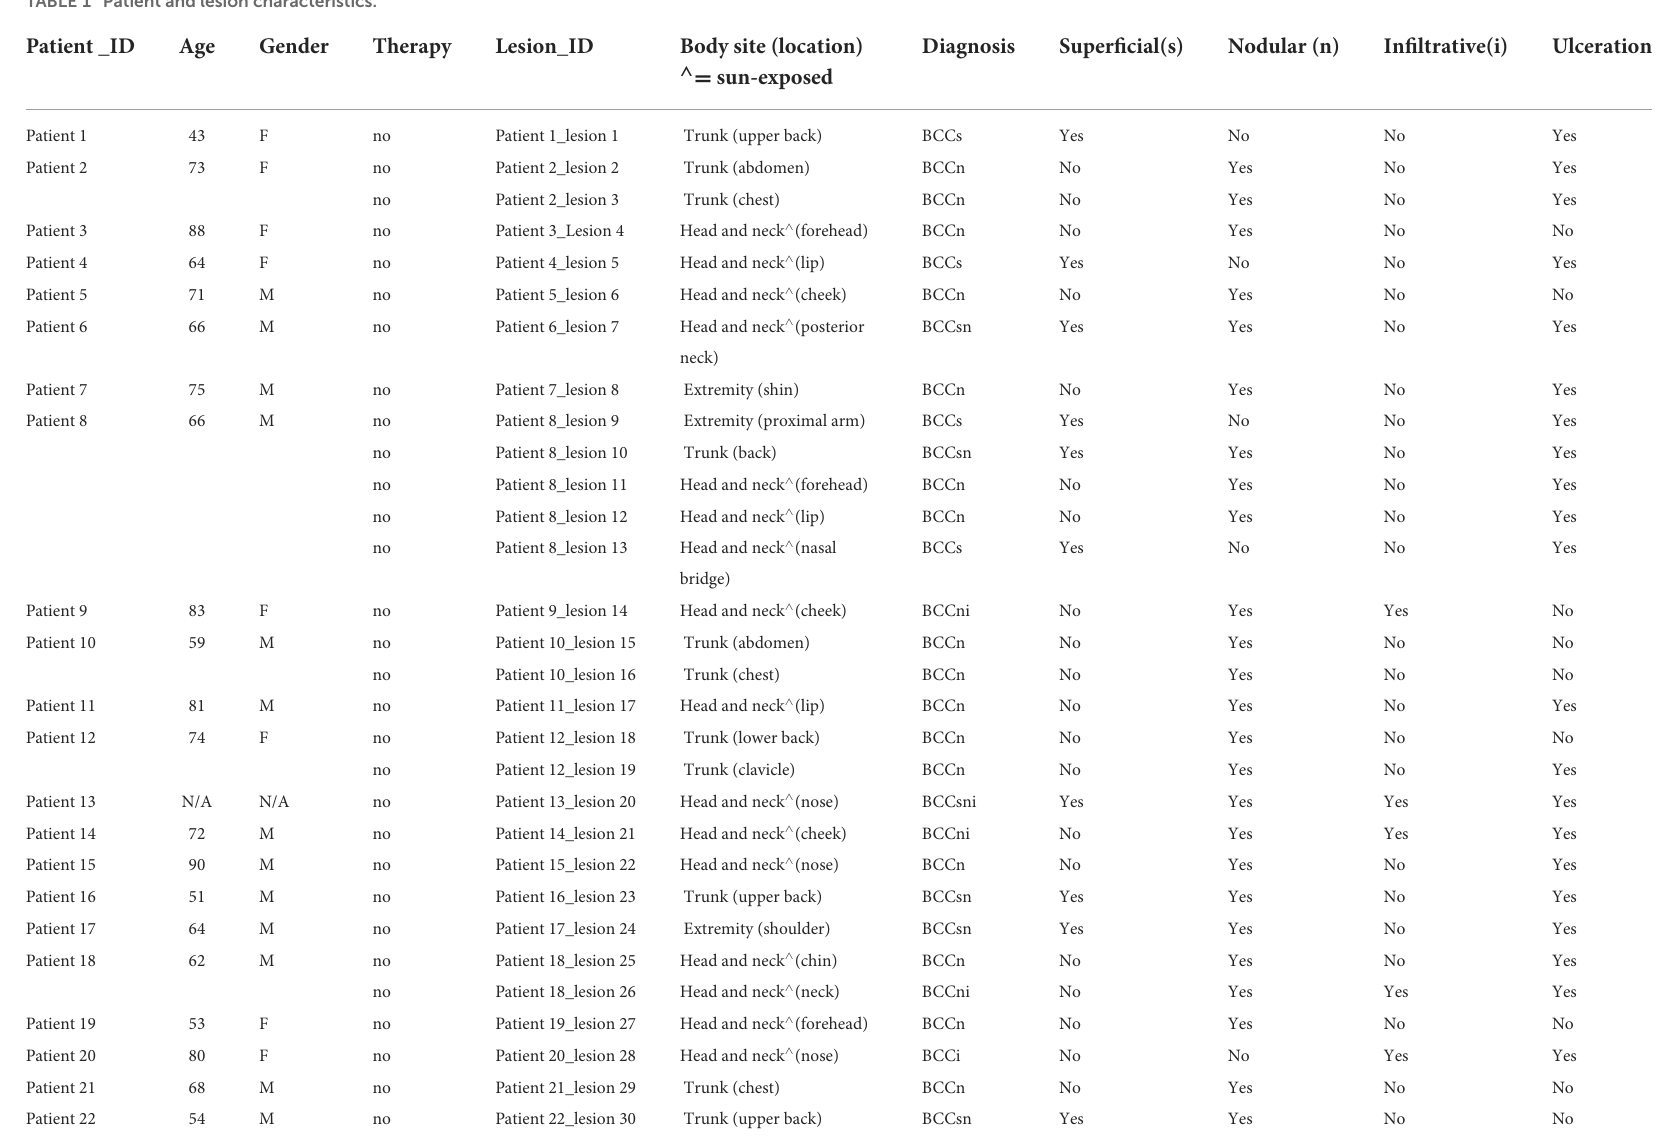
TABLE 1 Patient and lesion